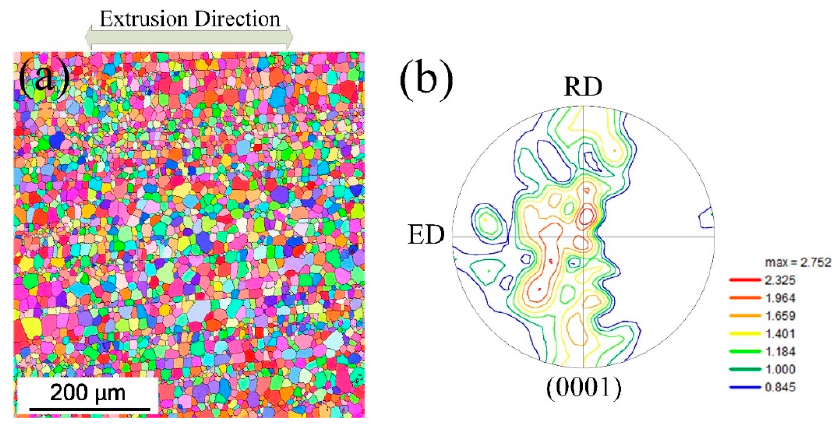
Figure 1. Initial Mg–8.0Gd–3.0Y–0.5 Zr alloy microstructure: ( a ) IPF map; ( b ) PF map.